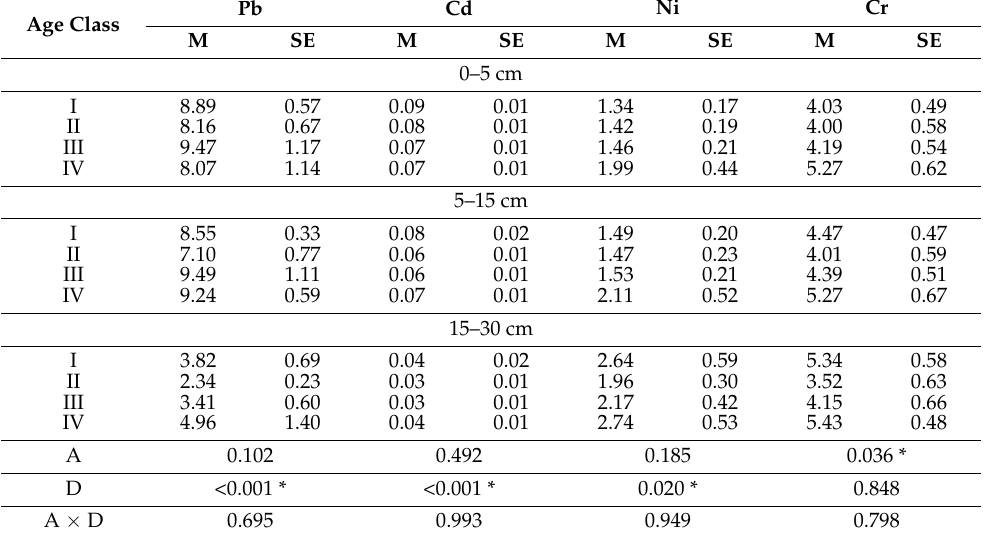
Table 6. Mean (M) with standard error (SE) concentrations (mg/kg of the soil) of heavy metals in the three top layers (0–5, 5–15 and 15–30 cm) of the soil under silver birch regeneration by age class (I, II, III and IV—1–4, 5–8, 9–12 and 13–17 years,